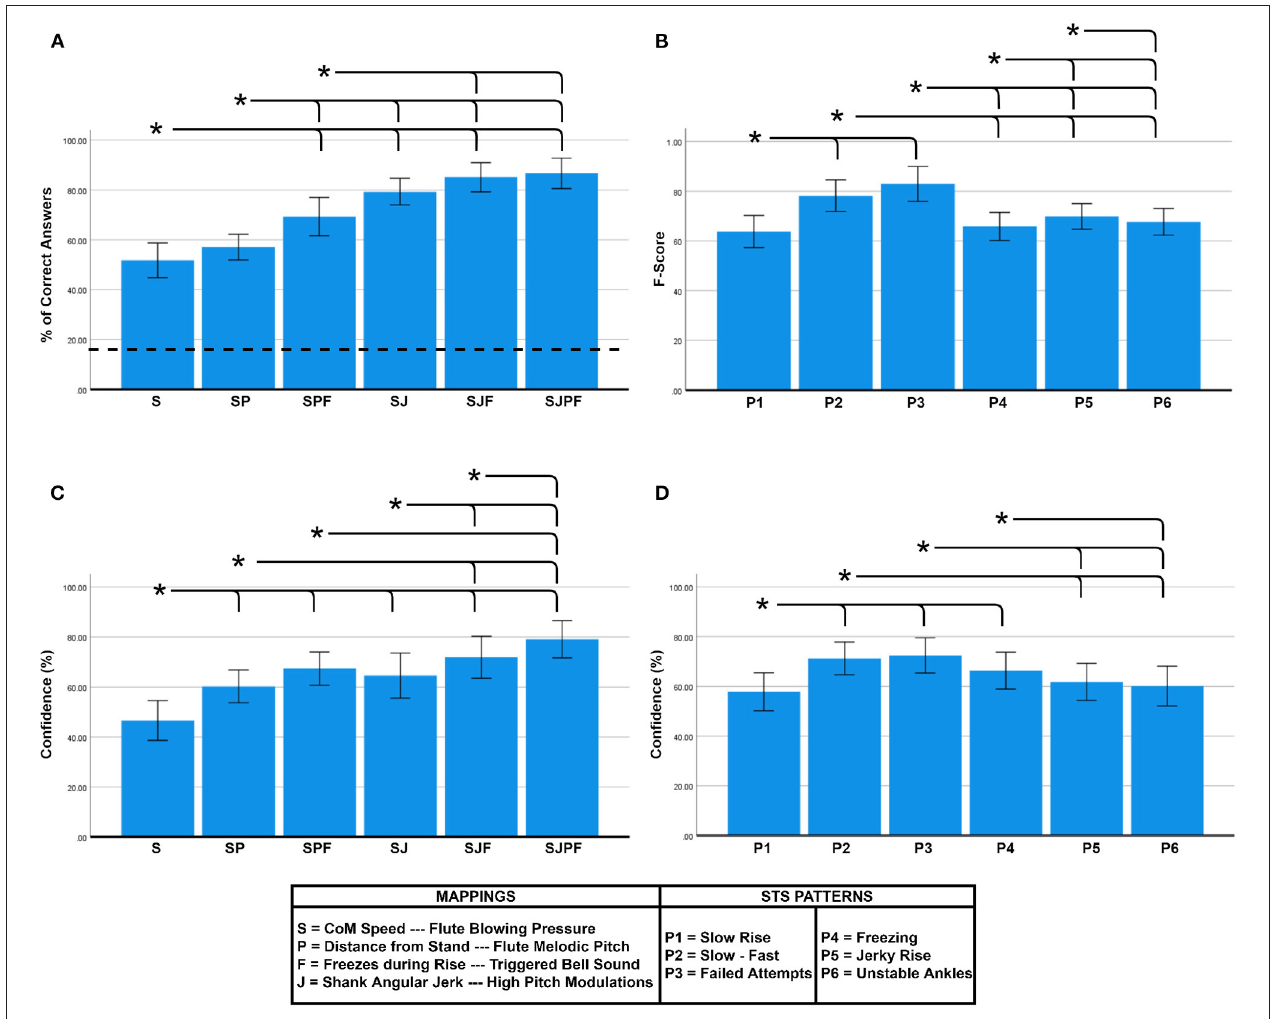
FIGURE 3 | (A) Accuracy comparison between parameter combinations, (B) F-score comparison between STS patterns, (C) Confidence comparison between parameter combinations, and (D) Confidence comparison between STS patterns. Bar heights indicate mean values, and the error bars show 95% confidence intervals. Asterisks indicate significant pairwise differences ( α = 0.05). Dotted line in (A) signifies chance level accuracy